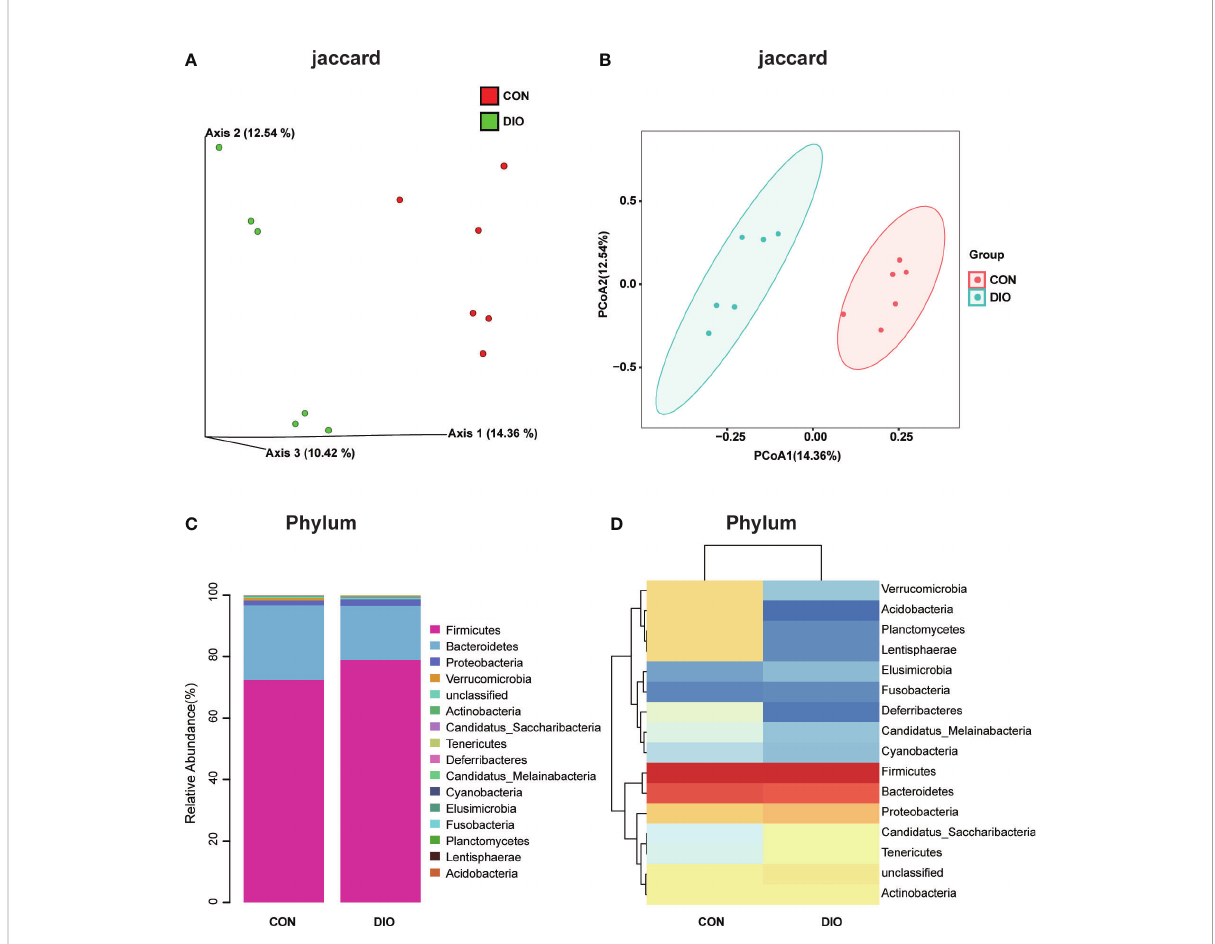
FIGURE 3 DIO signi fi cantly alters the abundance of gut microbiota. (A, B) 3D and 2D PCoA of GM analyzed with Jaccard distance matrices, n = 6. (C) Stacked bar chart at the phylum-level in the CON and DIO groups, n = 6. (D) Heat map at the phylum-level in the CON and DIO groups, n =